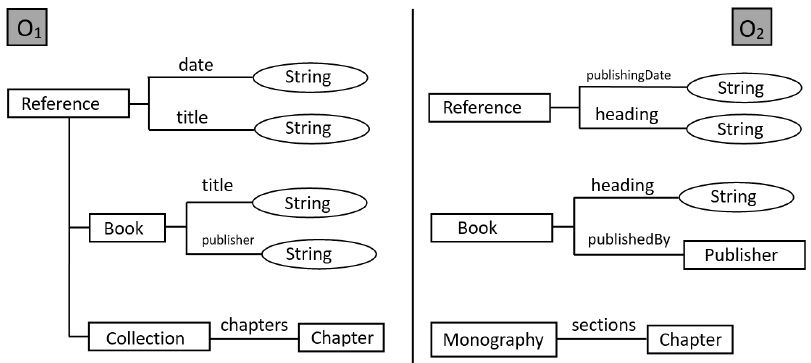
Figure 1. A segment of testing case from OAEI benchmark track.